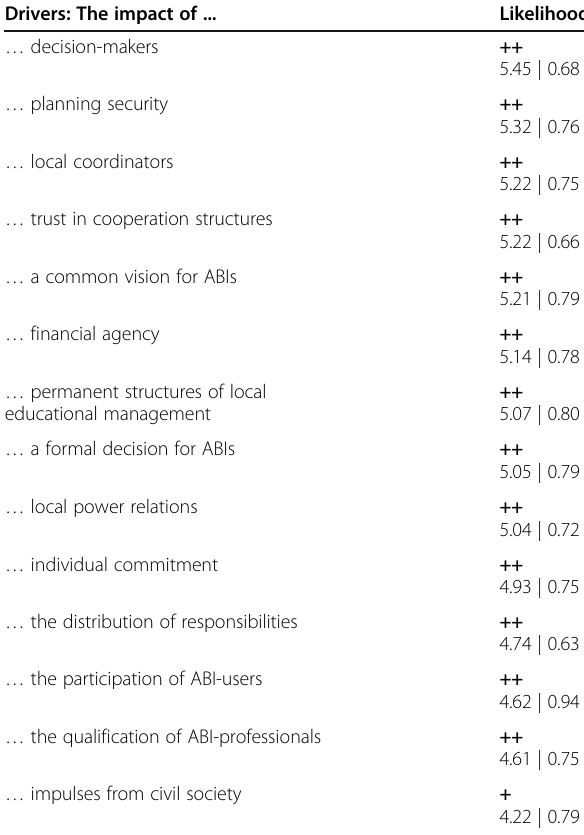
Table 11 Means and standard deviation of ABI drivers Drivers: The impact of